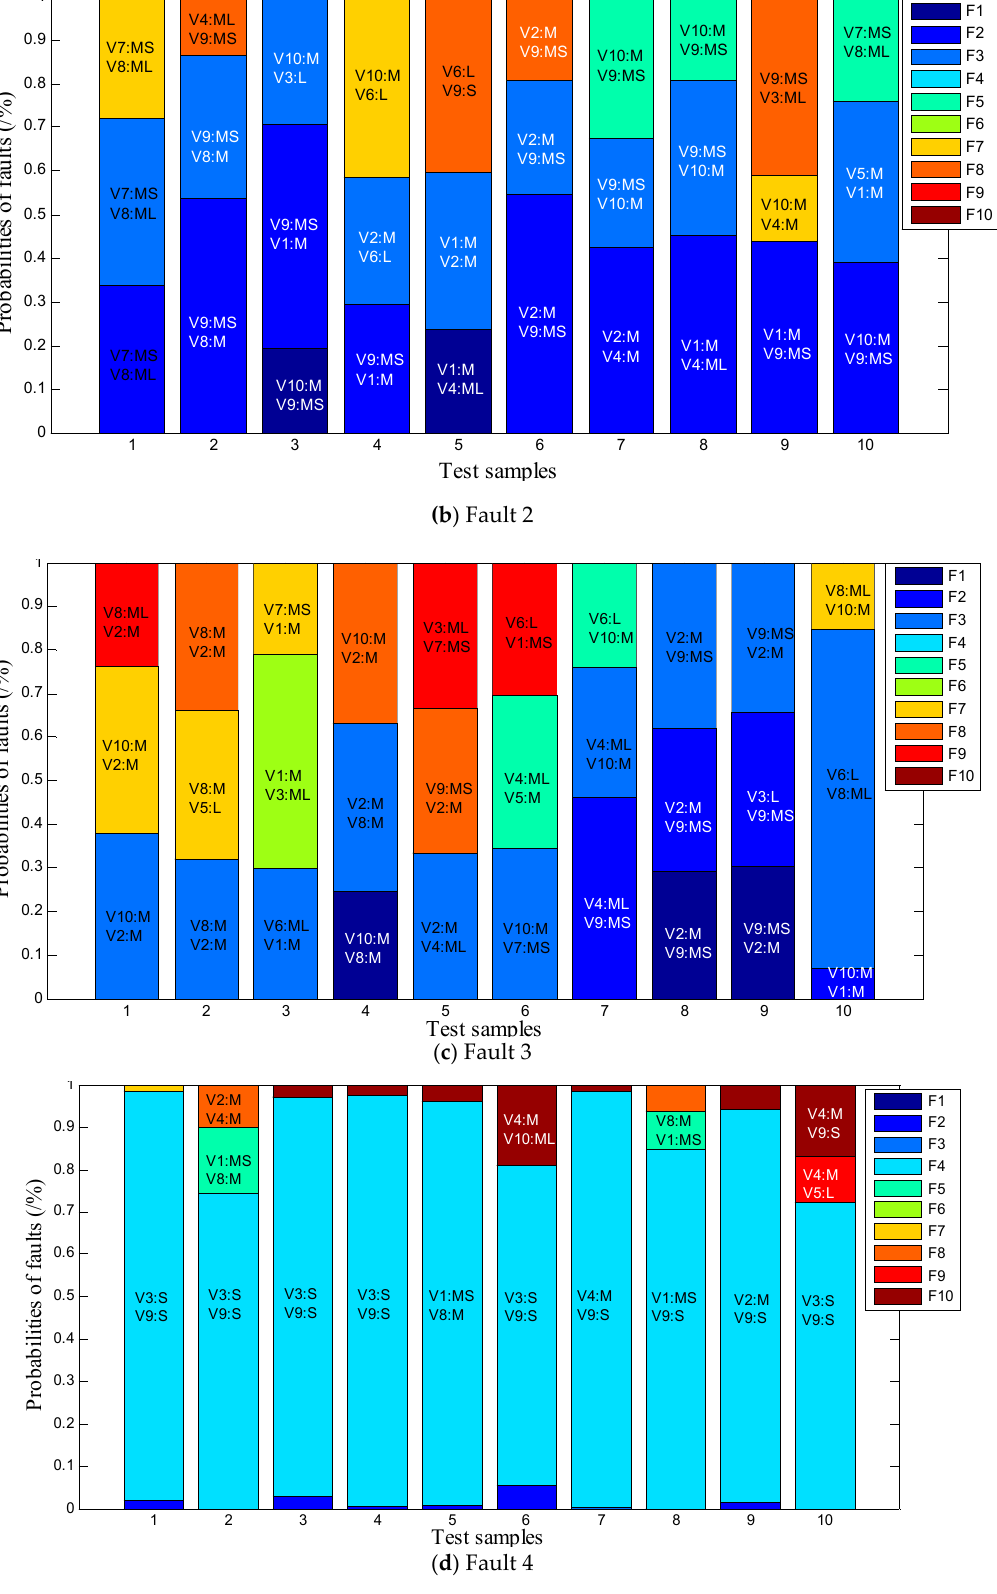
Figure 8. Cont. Figure 8.